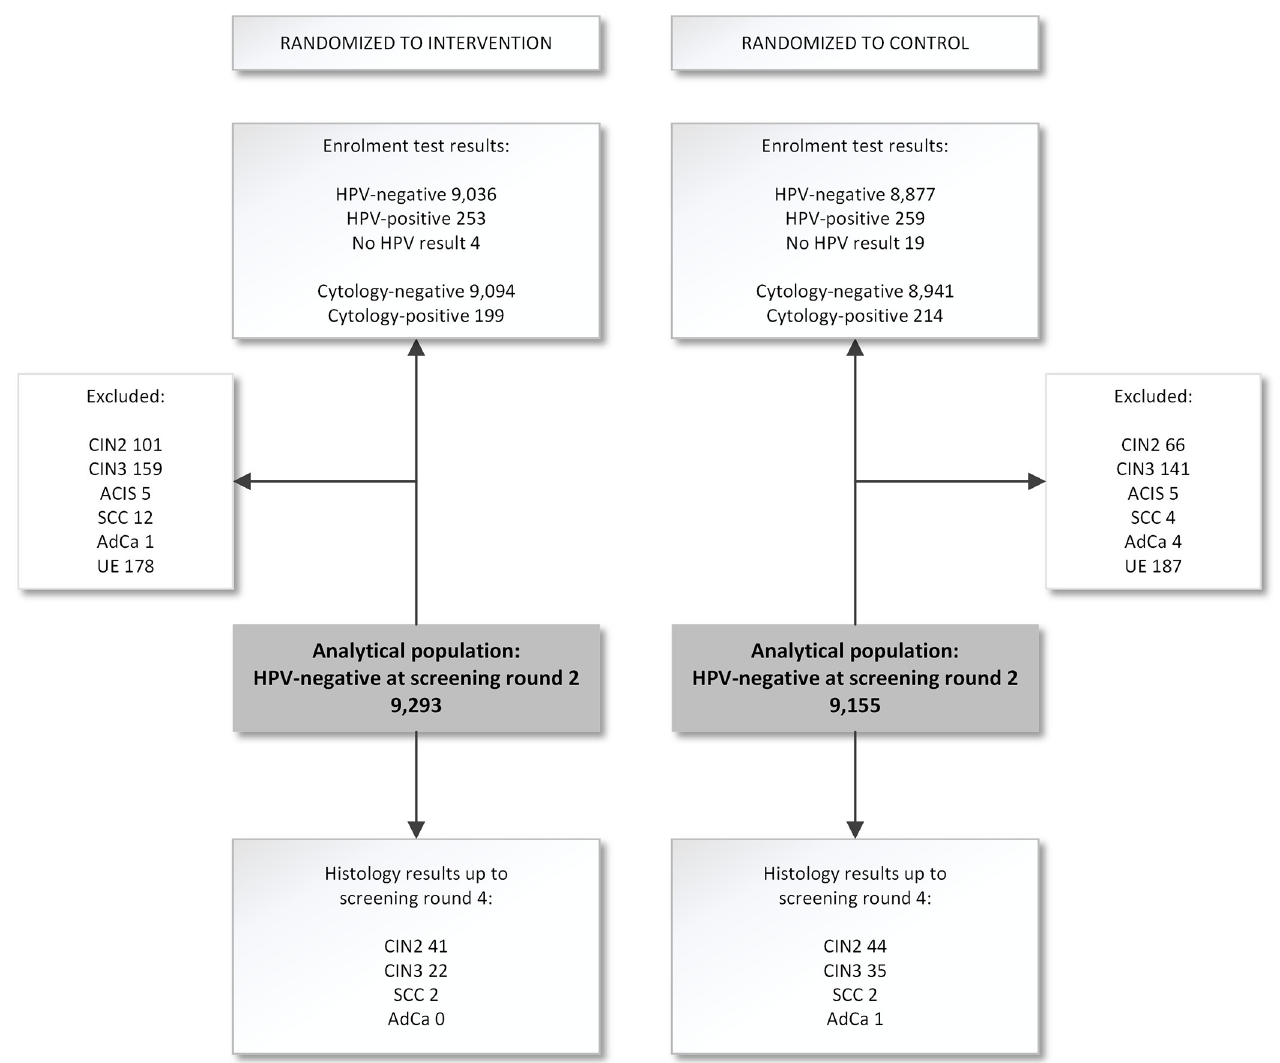
Fig 1. Flowchart of the 19 years of follow-up of the POBASCAM trial with focus on the analytical population consisting of 18,448 women who tested HPV–negative at the second screening round 5 years after enrolment. ACIS, adenocarcinoma in situ; AdCa, adenocarcinoma; CIN2/3, cervical intraepithelial neoplasia grade 2/3; HPV, human papillomavirus; SCC, squamous cell carcinoma; UE, uterus extirpation (hysterectomy).